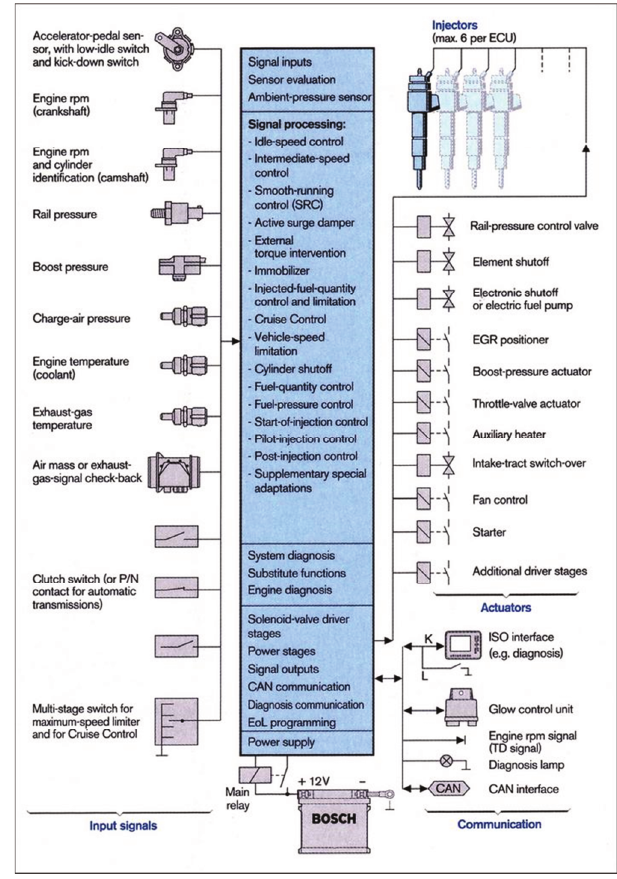
Fig. 1. An example engine control system used in a vehicle